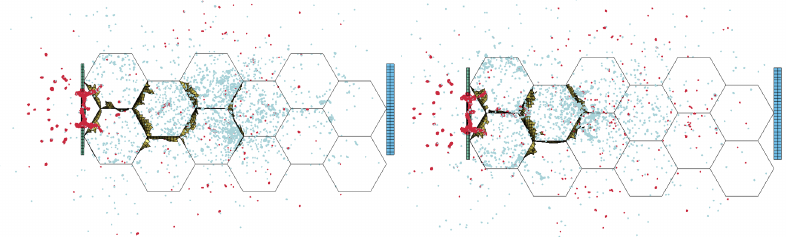
Figure 18. Numerical simulation comparing honeycomb shell materials: Al2024-T3 (model M-AL, left ) and Ti-6Al-4V (model M-TI, right